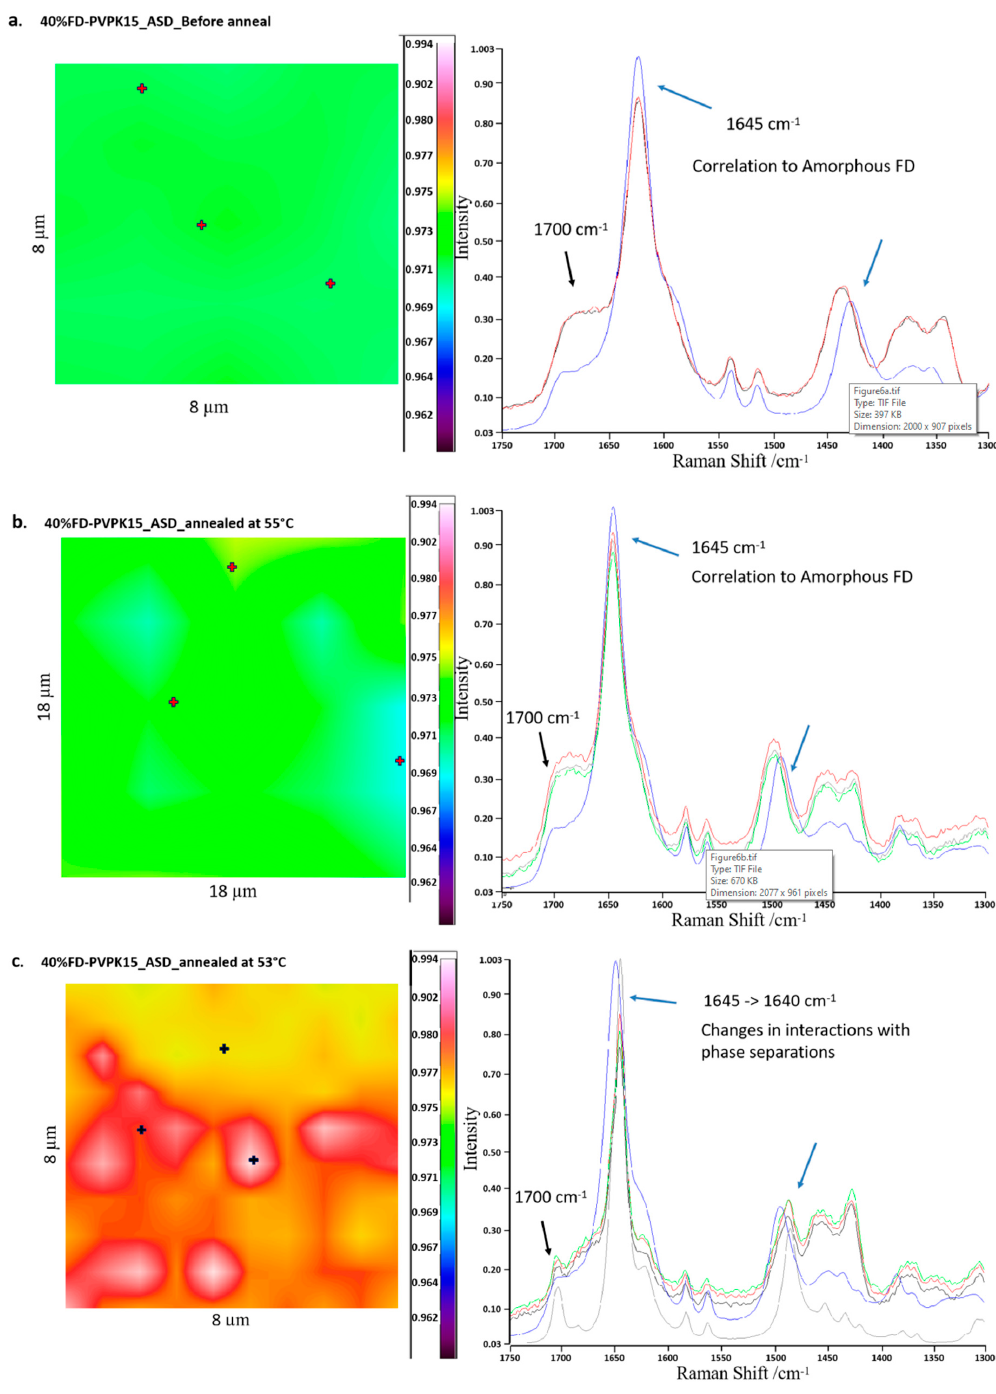
Figure 6. The micro-Raman chemical mapping and corresponding spectra (at selected spots) for FD in the regions between 1750–1300 cm − 1 for 40%FD-PVPK15 ASDs ( a ) before annealing and after annealing at ( b ) 55 °C and ( c ) 53 °C; the coloured scale bar represents the level of correlation to pure amorphous FD, white/red indicates high correlation and blue/black indicates low correlation. In conclusion, four points (triangle symbols) on the binodal line were confirmed by DSC (Figure 5) and micro-Raman chemical mapping, and shown in Figure 7. Circle symbols were verified by the DSC thermogrames as one phase system in Figure 5 (red lines), and square symbols were the conditions of the sample with AAPS observed in Figure 5 (black lines). Triangle symbols were in the average values of the circle and square points, which were further used to model the binodal lines within the ternary system. The corresponding temperatures and drug loadings at AAPS boundary were also summarized in Table 2. Samples annealed in the DVS at 90% RH for six hours were deemed sufficient for the water absorption (Supplementary Materials C), which were also sufficient for detecting the AAPS without substantial crystallization of amorphous FD. Although the phase separation occurs simultaneously for three components in the ternary system, only the aggregations of the amorphous FD from ASD were detected in our study by the high-speed DSC and micro-Raman mapping. The importance of water in a phase separated system might also be investigated by many advanced techniques, such as the transmission electron microscopy (TEM) with selected area electron diffraction (SAED) patterns [58]. The influences of mobile or bonded water on the dynamics of the AAPS, and, subsequently, the crystallization of amorphous drug from the ASD system remain of the highest interests in wide scientific fields. Figure 7. Four experimental points detected for aFD, PVPK15 and water ternary system, the binodal line was the boundary between one phase and AAPS.